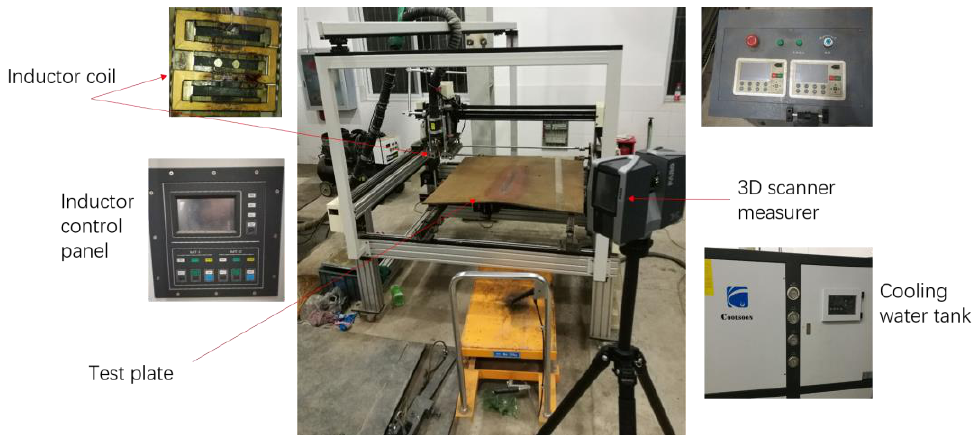
Figure 5. Experimental platform.